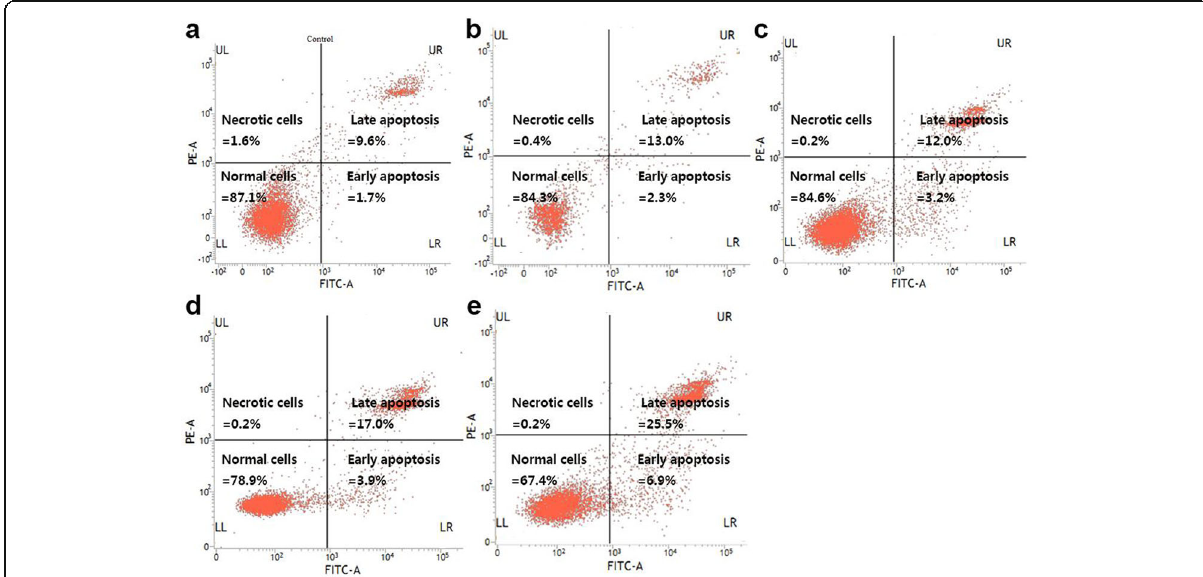
Fig. 3 Apoptosis of CTL treatment in A549 cells. The A549 cells were treated with varying concentrations of CTL ( a - e : 0, 10, 20, 30 and 40 μ g/mL) for 48 h. Then, the A549 cells were stained with propidium iodide (PI) and Annexin V-FITC as described in Methods. The stained A549 cells were analyzed for apoptosis by using a FACS Calibur flow